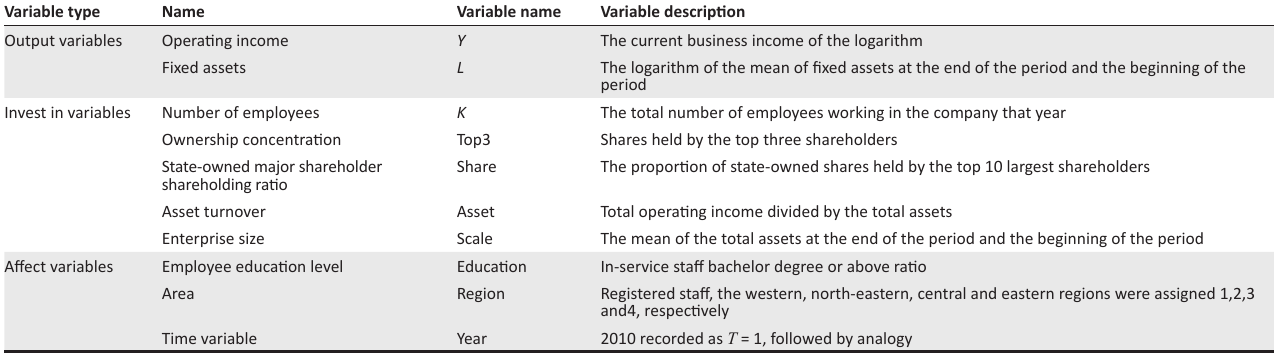
TABLE 1: Variable description. Variable type